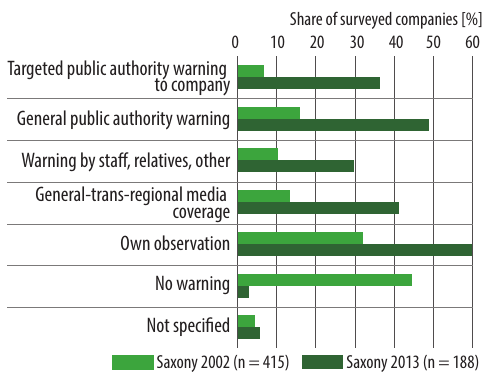
Figure 3. Answers of the interviewed companies in Saxony in re- sponse to the question of how they became aware of the imminent flood danger.